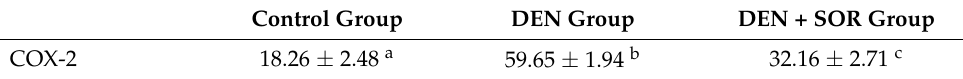
Table 2. Scoring immunohistochemical results for lung tissues.